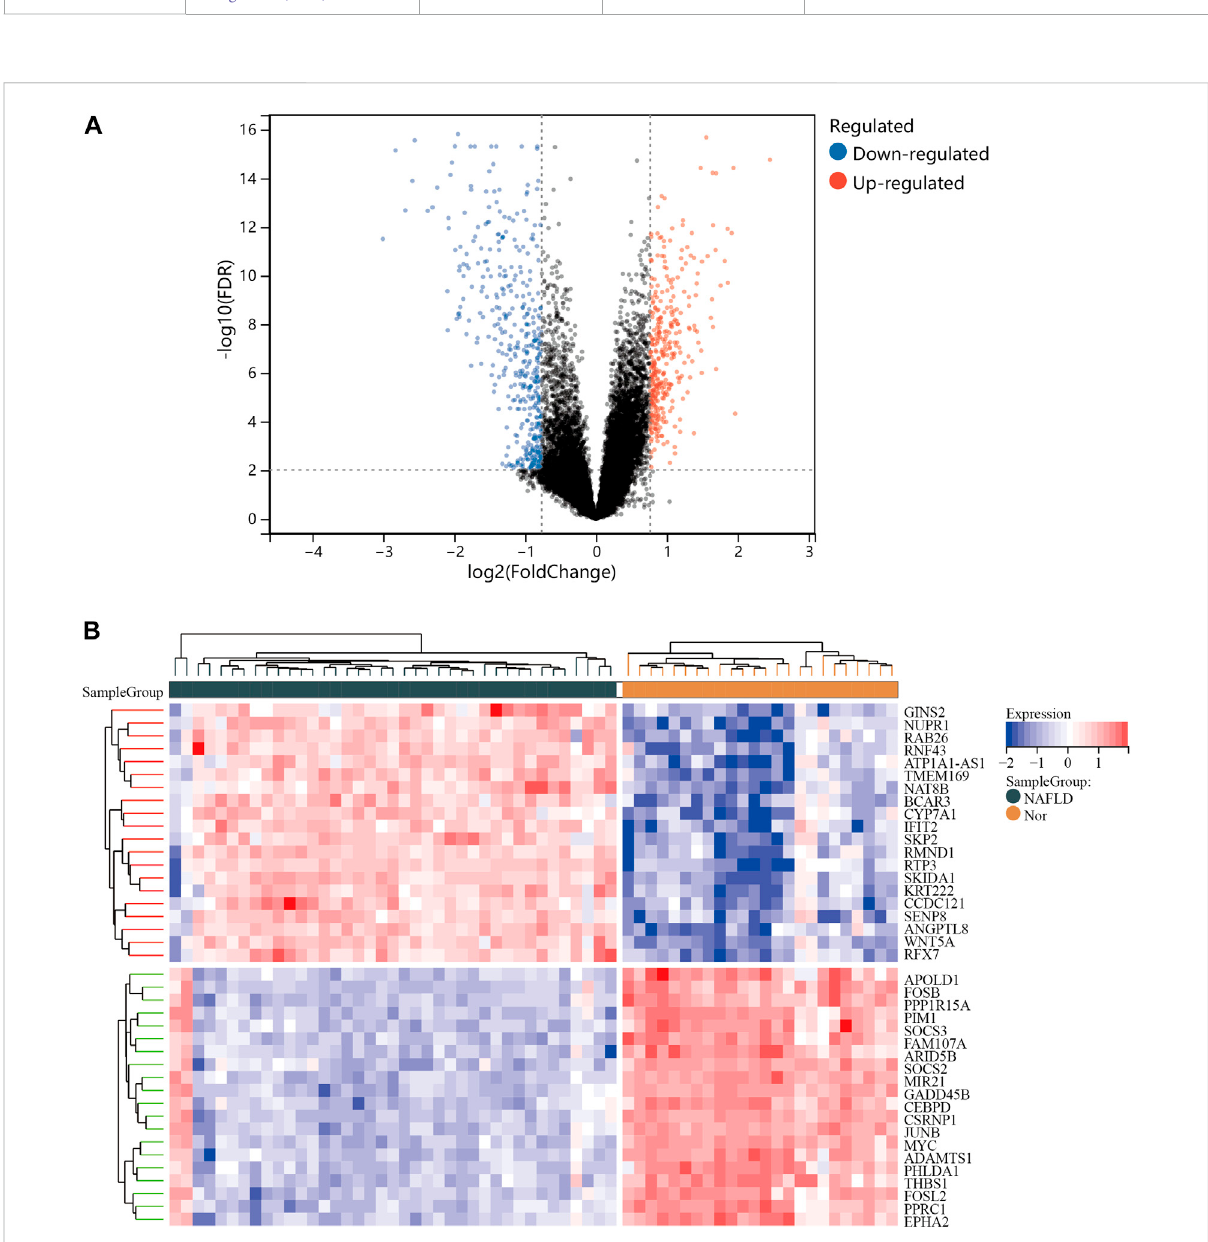
FIGURE 2 Differentiallyexpressedgenes(DEGs)fortheGSE89632dataset. (A) ,volcanoplotdepictingthestatusofgeneexpressionbetweenpatientswith NAFLD and normal controls. (B) , heatmap of the top 40 DEGs. Regions in red and blue are displayed to distinguish between the up- and down- regulation of